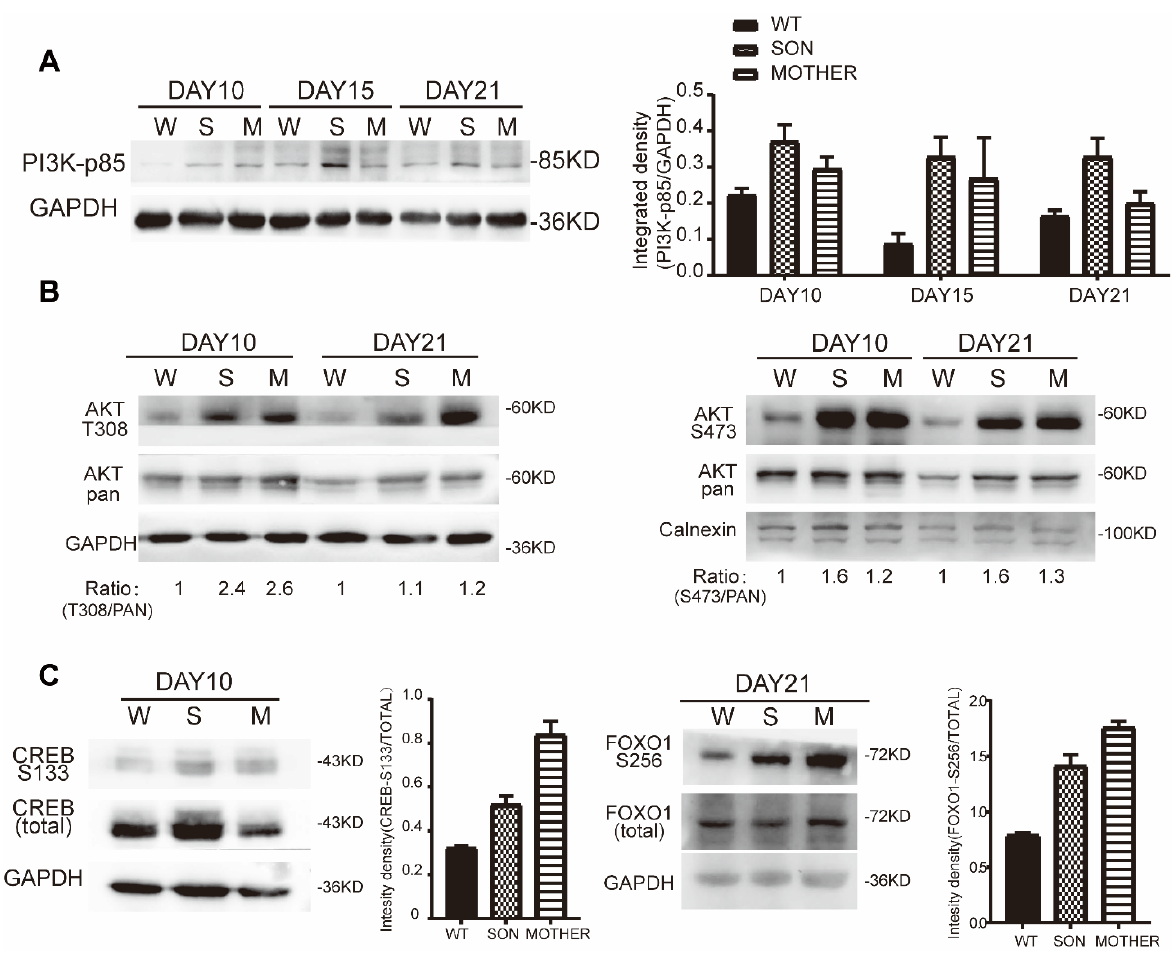
Figure 4. The increased expression of GLP-1R was accompanied by increased phosphorylation levels of key factors in the PI3K/AKT pathway in MEN1-derived cells. ( A ) The protein expression of PI3K-p85 between cell lines from PPC to IPC stage, n = 3; ( B ) p -AKT S473 and T308 phosphorylation was induced in MEN1-derived cells from PPC to IPC stage, respectively, n = 3; ( C ) AKT downstream transcription factor FOXO1 and CREB expression, n = 3; W-WT, S-SON, M-MOTHER.